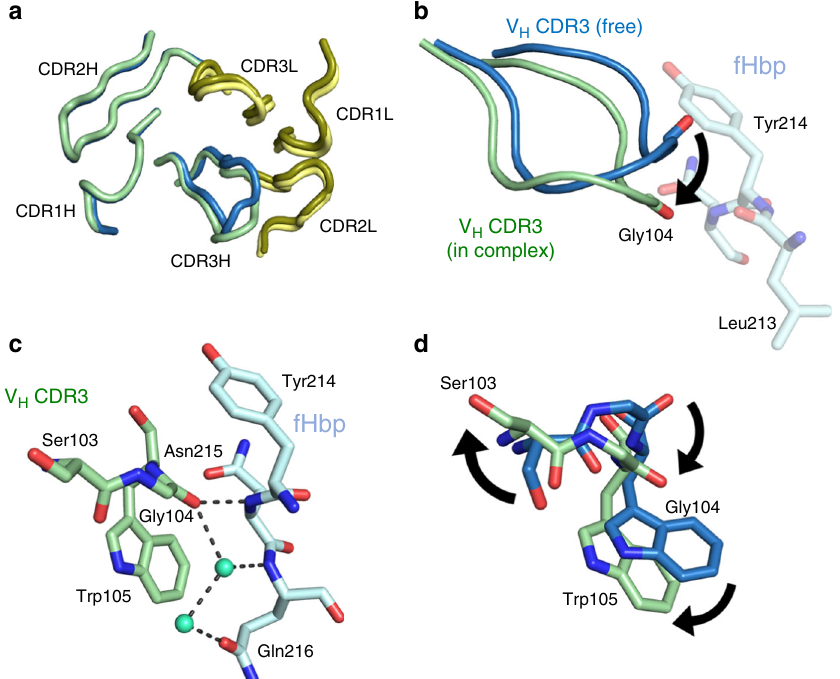
Fig. 7 Conformational changes between bound and free Fab 1A12. a Ribbon diagram showing the light (dark and light yellow) and heavy chains (green and blue) of Fab 1A12 both in the liganded (pale colors) and unliganded (dark colors) states. Only CDR3H shows a notable difference. b V H CDR3 loop conformations are represented as cartoons with colors distributed in a similar manner to a ; fHbp residue is colored cyan. The movement of Gly104 is indicated. c Detail of the Gly104 region in the bound state. d Side chains of Ser103 and Trp105 show notably different positions in bound and free forms